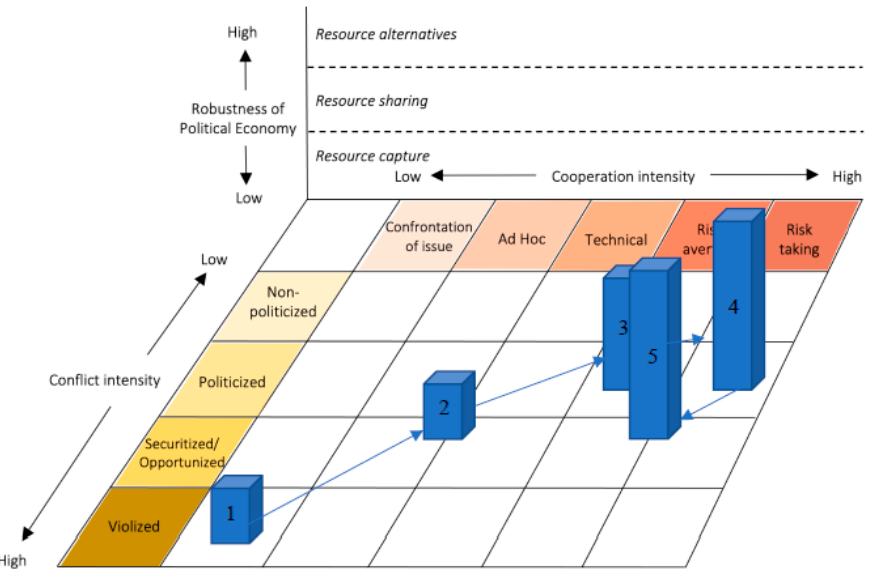
Figure 2. TWINS representation of Israel–Jordan interactions over transboundary waters.